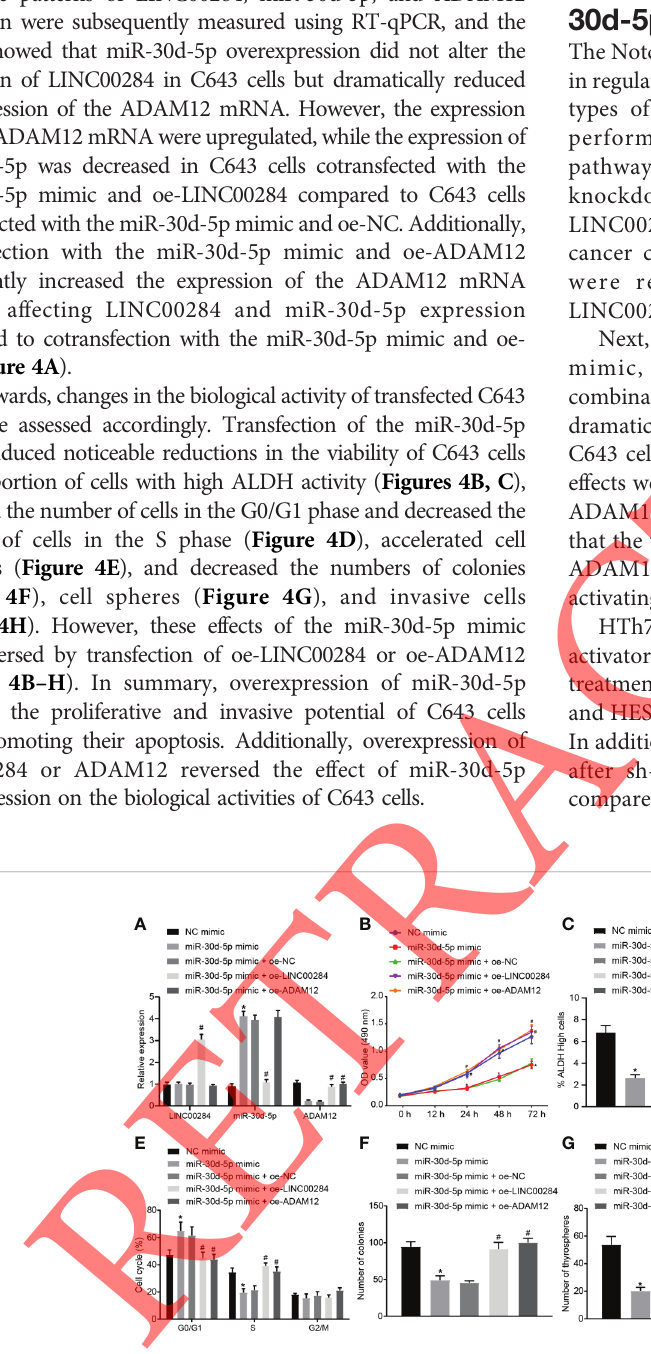
FIGURE 4 | The effect of the LINC00284/miR-30d-5p/ADAM12 axis on the biological activity of thyroid cancer cells. (A) The expression of LINC00284, miR-30d-5p and ADAM12 mRNA in C643 cells was determined using RT-qPCR. (B) The viability of C643 cells was determined using the MTT assay. (C) The ALDH activity of C643 cells was determined using the ALDEFLUOR experiment. (D) Flow cytometry analysis of the cell cycle of C643 cells d. (E) The apoptosis of C643 cells was determined using fl ow cytometry. (F) The colony formation ability of C643 cells. (G) Self-renewal ability of C643 cells assessed using the cell sphere formation assay. (H) The invasive ability of C643 cells assessed using the Transwell assay. * p < 0.05 compared with cells transfected with sh-NC. Data are presented as the means ± standard deviations. Comparisons between two groups were analyzed using the unpaired t -test, comparisons among multiple groups were analyzed using one-way ANOVA, followed by Tukey ’ s post hoc test, and comparisons among groups at different time points were analyzed using repeated measures ANOVA with Tukey ’ s post hoc test. The experiments were repeated 3 times. # p < 0.05 compared with cells transfected with miR-30d-5p mimic +